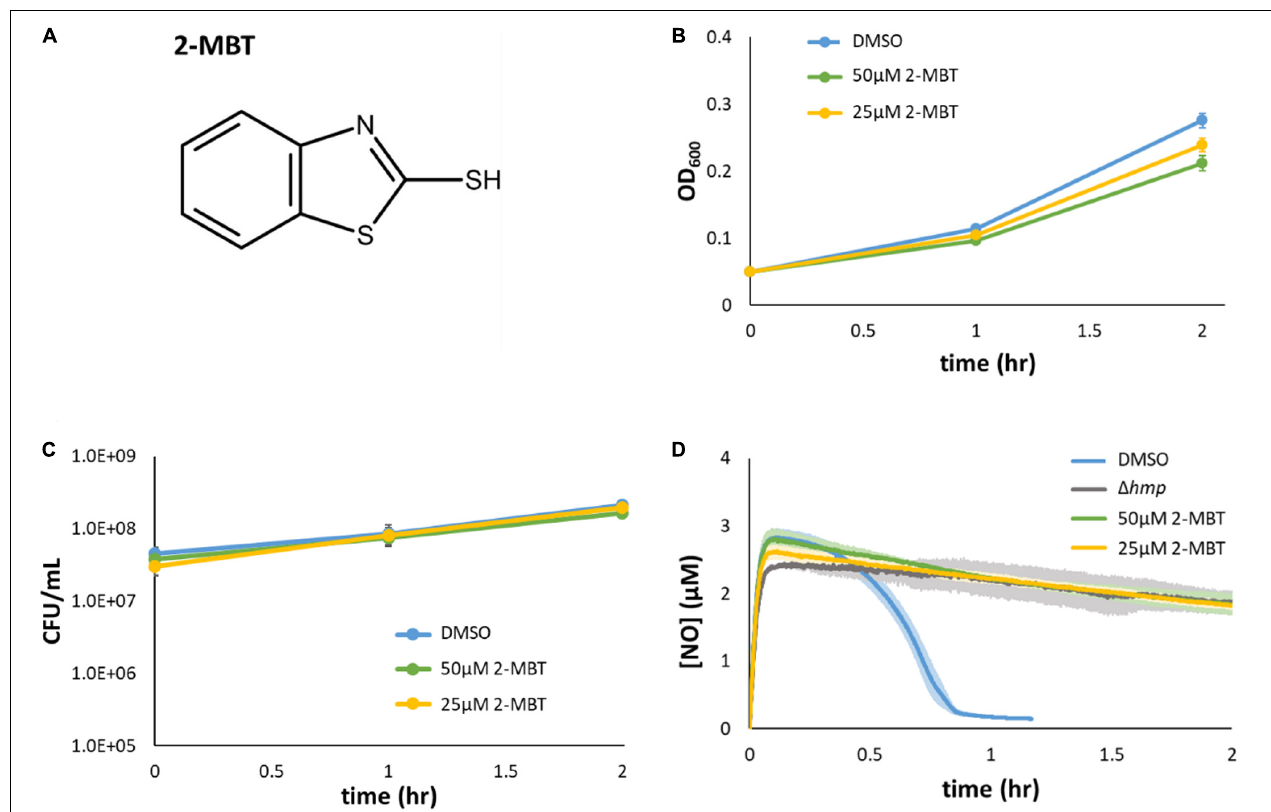
FIGURE 3 | Validation of 2-MBT activity. (A) The chemical structure of 2-mercaptobenzothiazole (abbreviated as 2-MBT) was drawn using ACD/ChemSketch (ACD/ChemSketch, 2020). (B,C) Bacteria were grown in liquid media in the absence of NO with different concentrations of 2-MBT. Growth (B) and culturability (C) were monitored hourly. Solid points represent the mean of at least 3 independent replicates and the error bars reflect the standard error of the means. (D) [NO] following compound and DPTA addition at time = 0 was continuously measured using a NO probe. Quickly after the addition of DPTA, [NO] peaked at ∼ 3 µ M. The time of NO clearance was identified as when [NO] ≤ 0.2 µ M, which corresponded to ∼ 0.95 h for cells treated with DMSO. In (cid:49) hmp , the dominant NO detoxification enzyme under oxygenated conditions is absent, and therefore, the gray line corresponds to negligible cellular detoxification of NO. Solid lines are the average measurements of at least 3 biological replicates, and the shaded regions around the lines are the standard errors of the